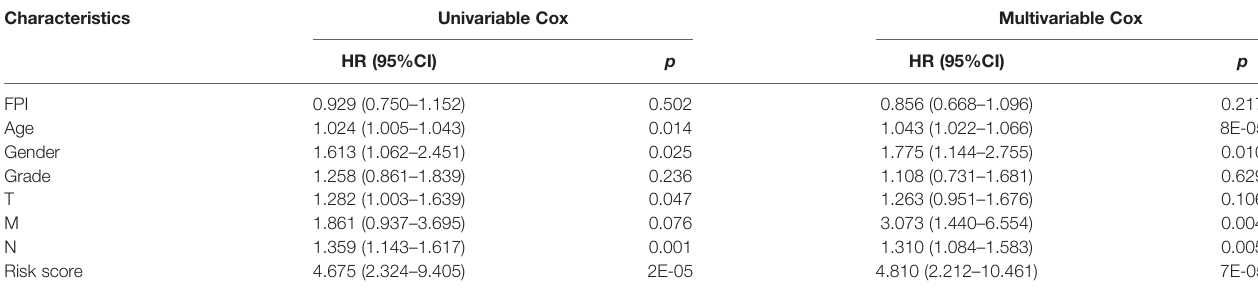
TABLE 4 | Cox regression analyses of clinical characteristics and survival in The Cancer Genome Atlas — stomach adenocarcinoma. Characteristics